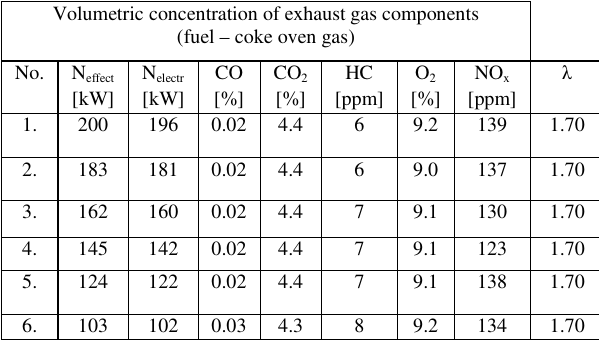
Table 1. Selected values of concentration of exhaust gas components, during coke oven gas engine fuelling Volumetric concentration of exhaust gas components (fuel – coke oven gas)